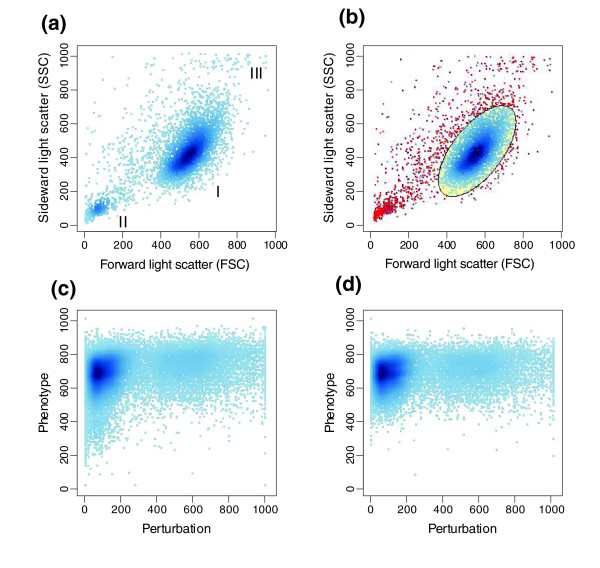
Selection of well measured cells. (a) Scatterplot of FACS data showing typical properties of morphologic parameters. FSC corresponds to cell size and SSC to cell granularity. Several subpopulations can be distinguished: (I) healthy and well measured cells, (II) cell debris, and (III) cell conjugates and air bubbles. (b) Robust fit of a bivariate normal distribution to the data. The ellipse represents a contour of equal probability density in the distribution and is used as a user-defined cut-off boundary (two standard deviations in this example). Points outside the ellipse (marked in red) are considered contaminants and are discarded from further analysis. Scatterplots of perturbation versus phenotype (c) before and (d) after removing contaminants. The proportion of outlier data points is reduced significantly. Here, they correspond to measurements with very small phenotype values (cell debris). FACS, fluorescence-activated cell sorting; FCS, forward light scatter; SSC, sideward light scatter.